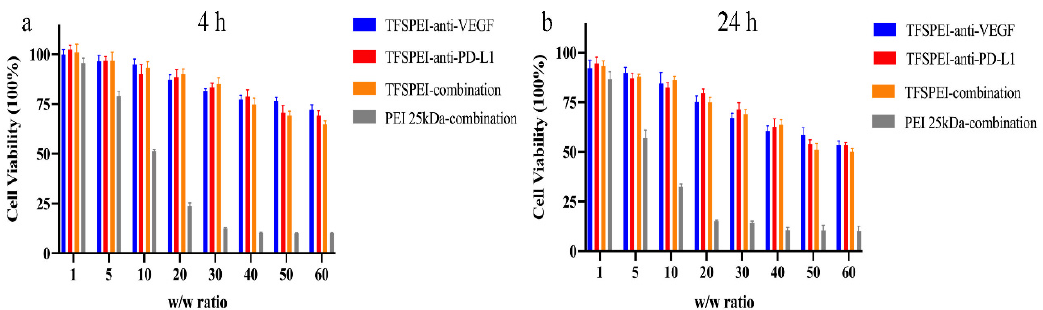
Figure 5. Cell viability of CT26 of four groups (TFSPEI-anti-VEGF polyplex, TFSPEI-anti-PD-L1 polyplex, TFSPEI-combination polyplex, and PEI 25 kDa-combination polyplex) at different w / w ratios (1, 5, 10, 20, 30, 40, 50, 60) incubated for ( a ) 4 h and ( b ) 24 h. Data are shown as the mean ± S.D. (n = 6).